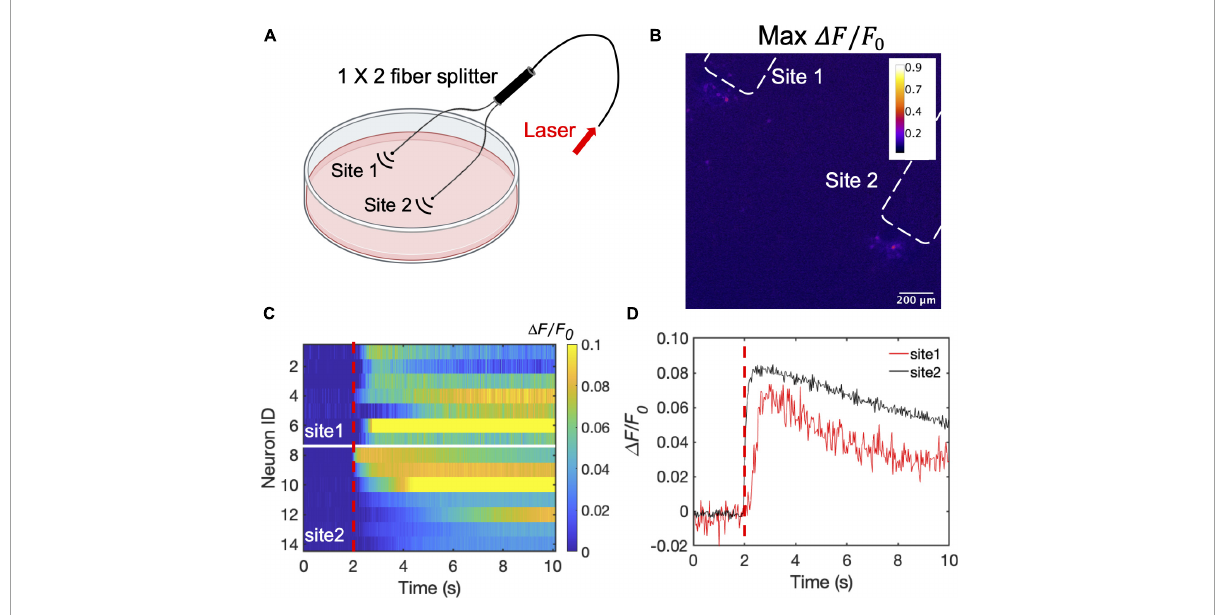
FIGURE5 Dual site neuron stimulation by CSFOE. (A) Schematic of dual site stimulation using two CSFOEs with a fiber splitter. Created with BioRender.com. (B) Map of the max (cid:52) F / F 0 image of two sites of neurons stimulated by two CSFOE. (C) Colormaps of fluorescence changes in neurons at two sites stimulated by CSFOE. (D) Representative calcium traces from traces shown in (C) from neurons at site 1 (Red) and site 2 (Black).